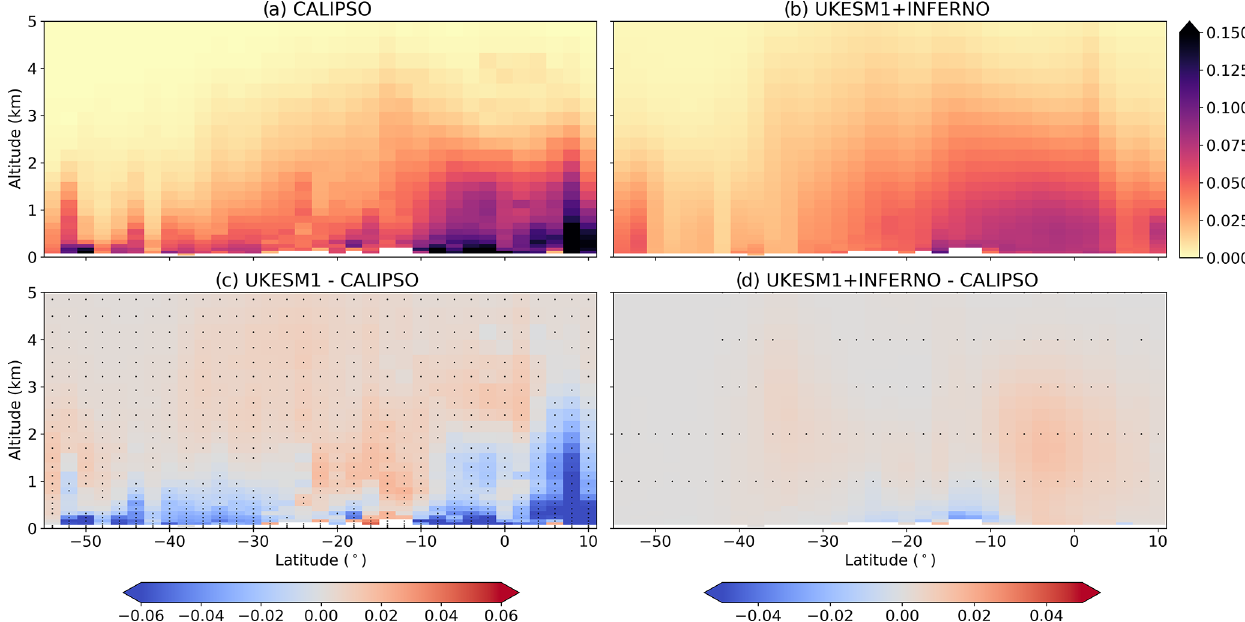
Figure 15. Aerosol extinction coefficient mean annual average vertical cross section at 532nm (2006–2014) covering the South Ameri- can continent (extending both NHSA and SHSA regions) for (a) CALIPSO, (b) UKESM1+INFERNO, (c) difference between UKESM1 and CALIPSO, and (d) difference between UKESM1+INFERNO and UKESM1. Stapling is shown for points where the differences are statistically significant with a 95% confidence